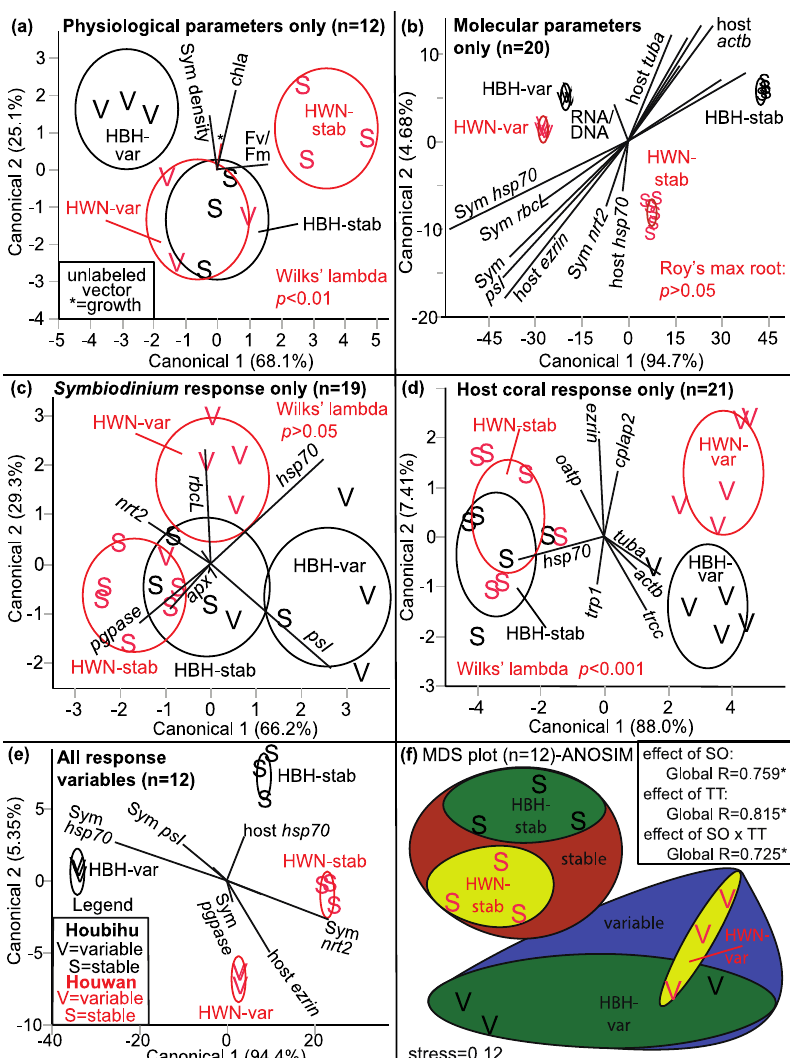
Figure 6. Multivariate analysis of variance (MANOVA) and multidimensional scaling (MDS) analysis of the Seriatopora hystrix variable temperature study (SHVTS). MANOVA was used to model differences between the four site of origin (SO) × temperature treatment (TT) interaction groups with four of the five physiological parameters (excluding areal chlorophyll a (chla a ); ( a )), all 17 molecular response parameters ( b ), seven of the eight Symbiodinium ( Sym ) molecular response variables (excluding the ribulose ‐ 1,5 ‐ bisphosphate carboxylase/oxygenase (large subunit) protein (RBCL); ( c) ), all eight host coral mRNAs ( d ), and all 23 response variables ( e ). The sample sizes displayed in the individual panels reflect the number of samples and not the number of response variables. Wilks’ lambda could not be computed in ( b ) and ( e ) due to the large number of response variables relative to the number of samples. In ( b ), not all axes have been labeled. In ( c ), the Sym genome copy proportion (GCP) axis falls between those of the mRNAs nitrate transporter ‐ 2 ( nrt2 ) and rbcL . In ( e ), only the dominant axes/response variables have been shown due to spatial constraints in the panel itself. In ( a – d ) Wilks’ lambda ( a , c , d ) and Roy’s max root ( b ) values test the interaction of SO and TT. In ( f ), PRIMER’s MDS function was used to portray the SHVTS dataspace, and the circles were hand ‐ drawn to encompass the four SO × TT groups. All other circles represent 95% confidence centroids. The legend in ( e ) corresponds to all panels. * Global R p < 0.01.